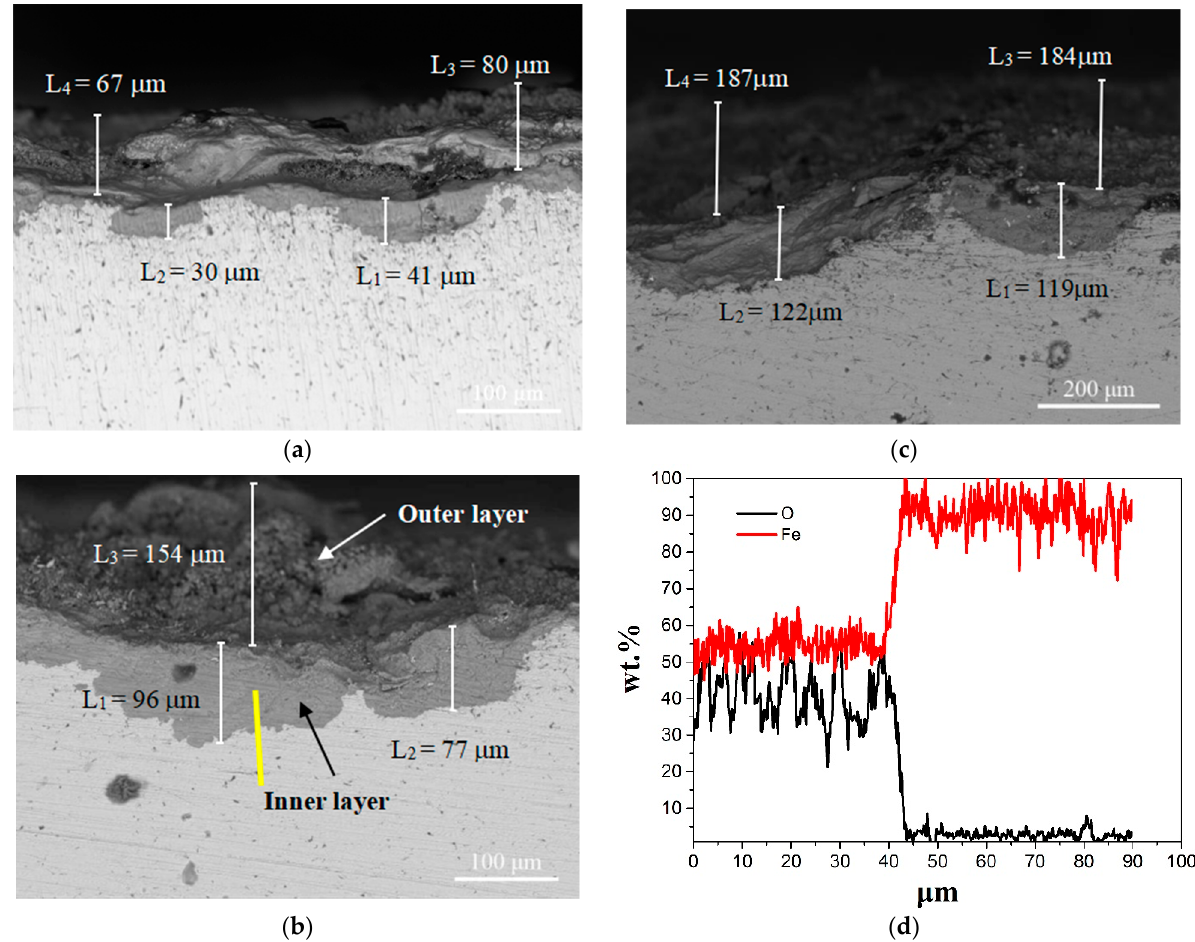
Figure 8. Cross-sectional morphologies of the rust layers and EDS analysis: ( a ) urban industrial atmospheric exposure for 12 months, ( b ) urban industrial atmospheric exposure for 41 months, ( c ) urban industrial atmospheric exposure for 84 months, and ( d ) EDS line surface scan image.